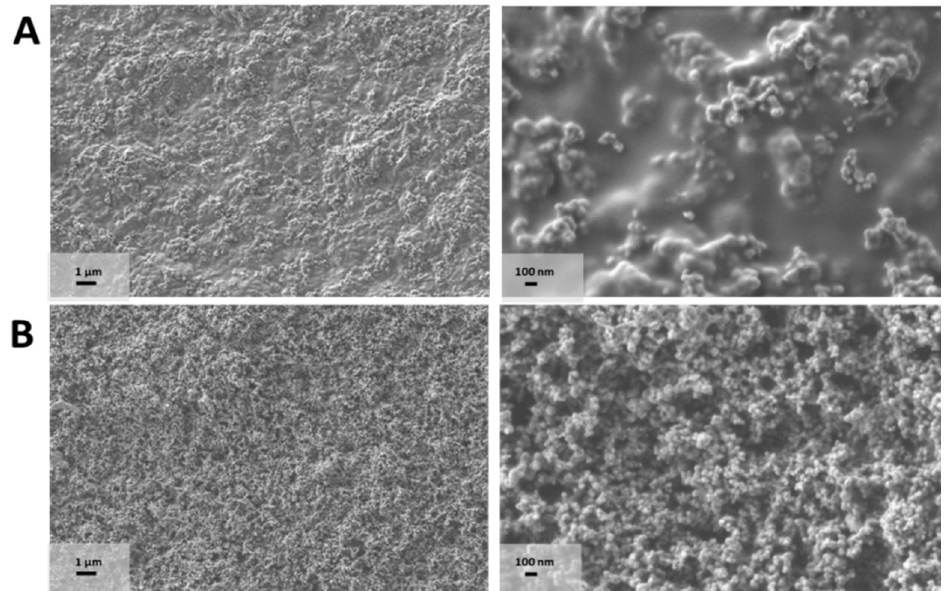
Figure 2. CH-CB membrane FESEM images of ( A ) 25 and ( B ) 100 w/w% CB recorded at 5 K × (left) and 30 K × (right).